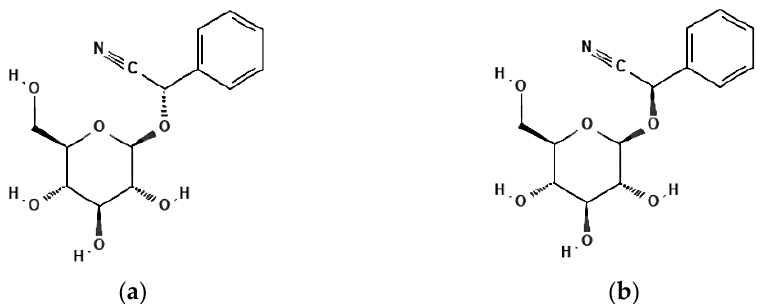
Figure 2. Chemical structure of: ( a ) sambunigrin and ( b ) prunasin.